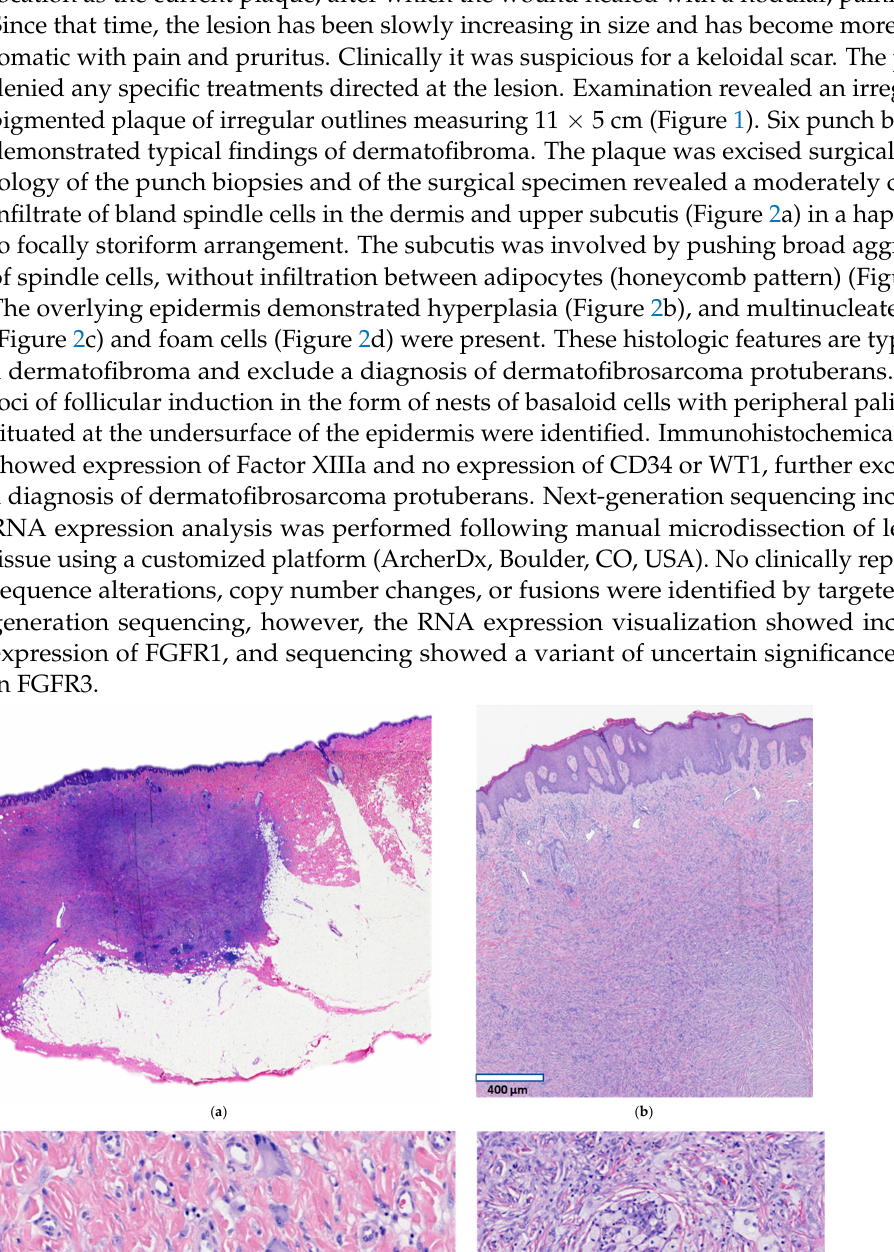
Figure 2. Histopathology of plaque-like dermatofibroma. Well-demarcated infiltrate of spindle cells in the dermis and upper subcutis ( a , b ) with overlying epidermal hyperplasia (( b ), scale bar: 400 µm), multinucleated cells (( c ), scale bar: 60 µm), and foam cells (( d ), scale bar: 100 µm).